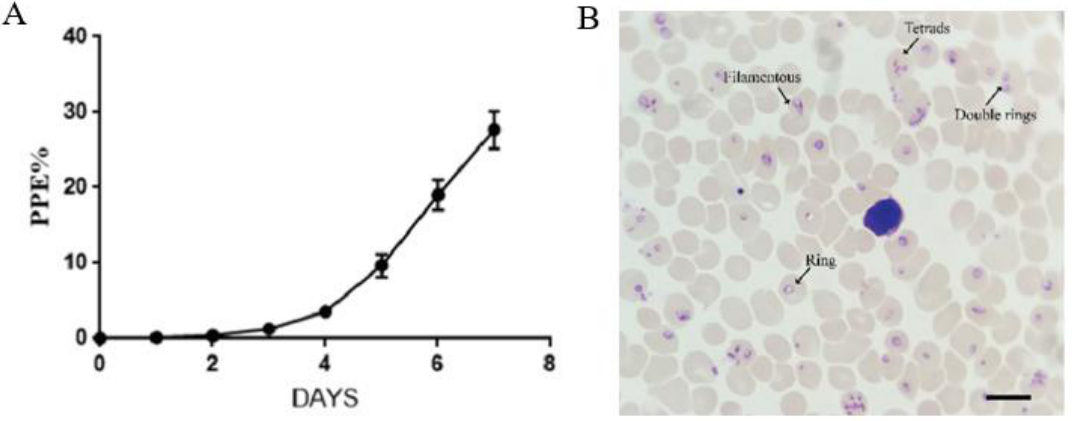
Figure 5. Serum-free culture of B. duncani infects Syrian Golden hamsters. ( A ) The PPE of B. duncani after intraperitoneal (n = 3). ( B ) Parasitic morphology of B. duncani in hamster erythrocytes in a Giemsa-stained smear prepared on day 5 after infection. The scale represents 10 μm.